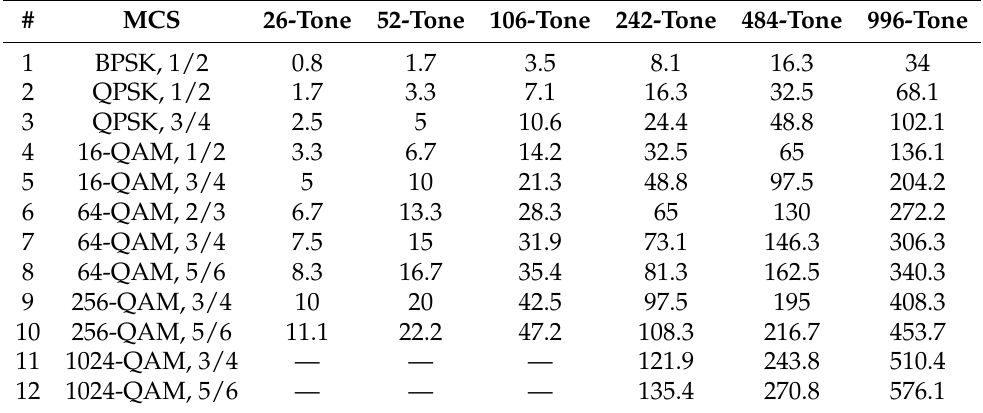
Table 1. Data rates in RUs with different number of tones, Mbps. Reprinted with permission from [8]. Copyright 2018 IEEE.